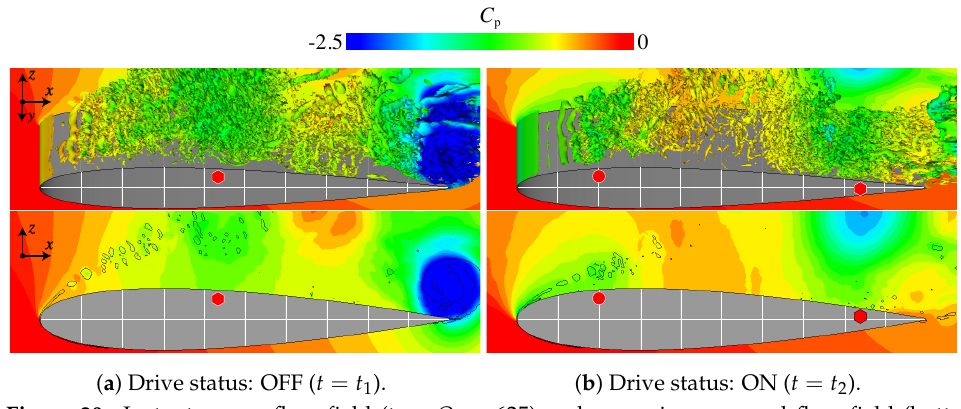
Figure 20. Instantaneous flow field (top, Q = 625) and spanwise-averaged flow field (bottom, Q = 125) with isosurfaces of the second invariant of the velocity gradient tensor ( Q ) colored based on C p in the DTM at α = 16. The red symbols denote the locations of representative spanwise vortices.